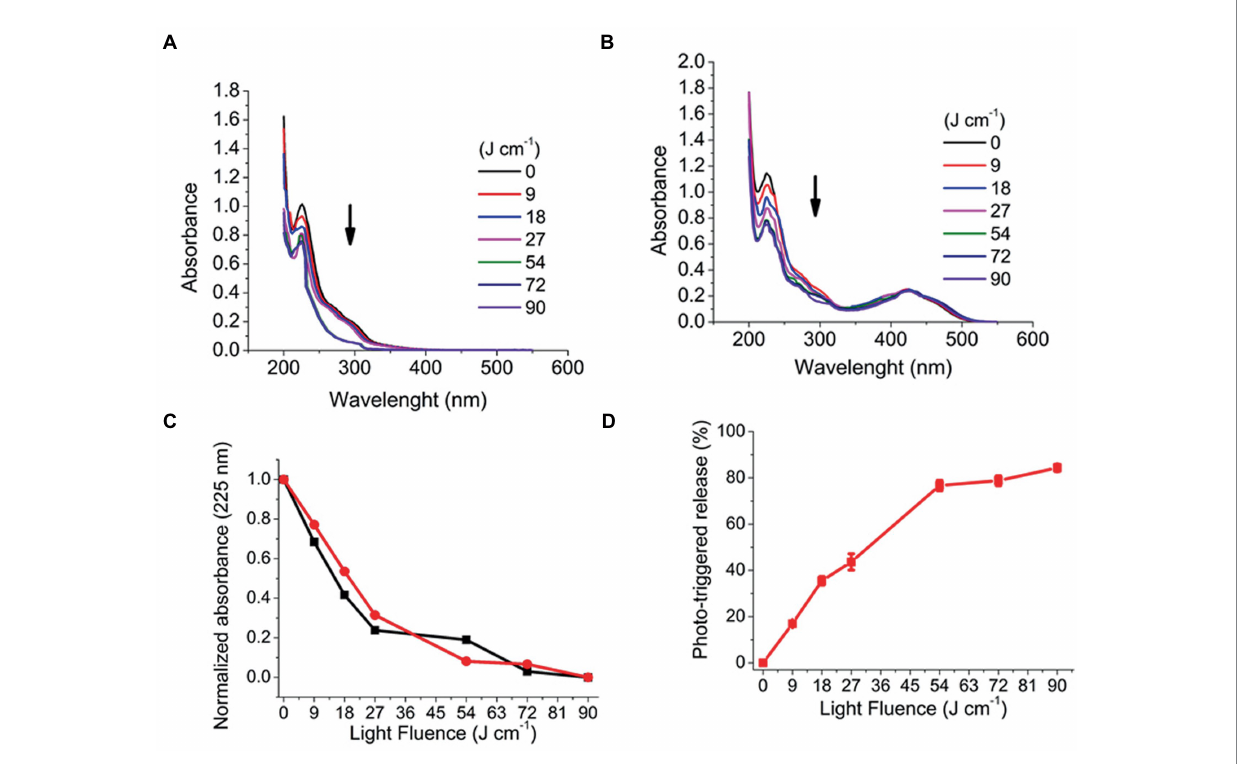
FIGURE 4 Photodegradation of PRP after irradiation with a UV laser light (355 nm, 25 mW/cm, from 6 to 60 min, corresponding to fluences of 9 to 90 J/cm). (A) Without CUR. (B) With CUR, arrows indicate decreased absorption spectra. (C) Normalized absorbance of photodegradation of PRP with CUR (black squares) and without CUR (red circles). (D) CUR release from PRP